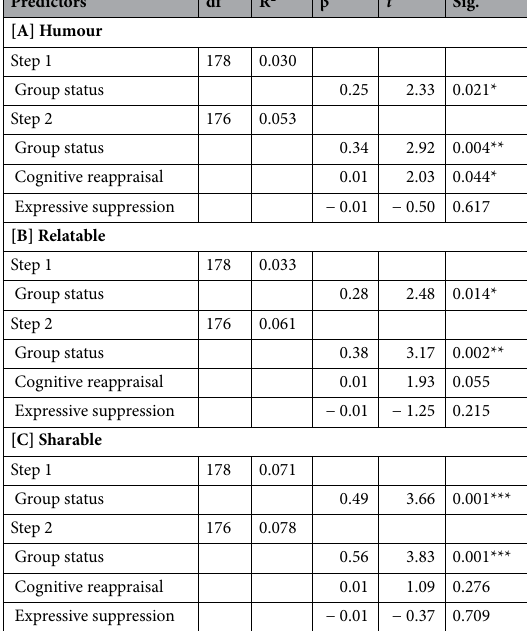
Table 2. Linear regression analyses with rating type as the dependant variables; and group status and emotion regulation subscales as predictors. 1000 bias corrected bootstrapped samples. ERQ, Emotion Regulation Questionnaire. *Sig at < 0.05, ** < 0.01, ***